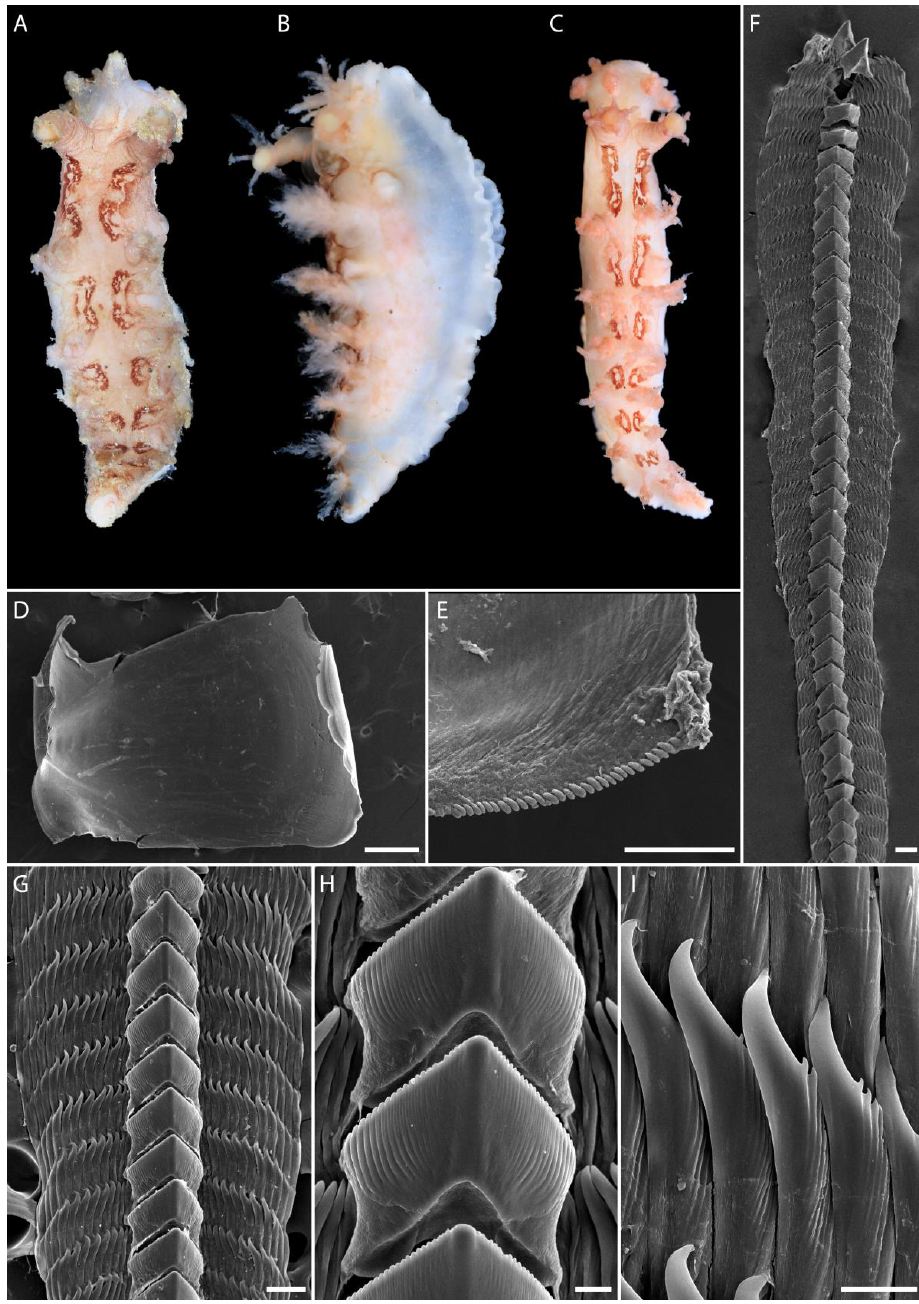
Figure 2. Dendronotus valdesi sp. nov., features of external and internal morphology (SEM). ( A ) — paratype MIMB44616, dorsal view. ( B ) — holotype MIMB44612, lateral view from the right. ( C ) — paratype MIMB44615, dorsal view. ( D ) — paratype MIMB44615, right jaw plate. ( E ) — paratype MIMB44615, masticatory process of the jaw. ( F ) — paratype MIMB44615, radula. ( G ) — paratype MIMB44615, posterior radular portion. ( H ) — paratype MIMB44615, rachidian teeth. ( I ) — paratype MIMB44615, lateral teeth. Scale bars: ( D ) = 500 µm; ( E – G ) = 100 µm; ( H , I ) = 30 µm.